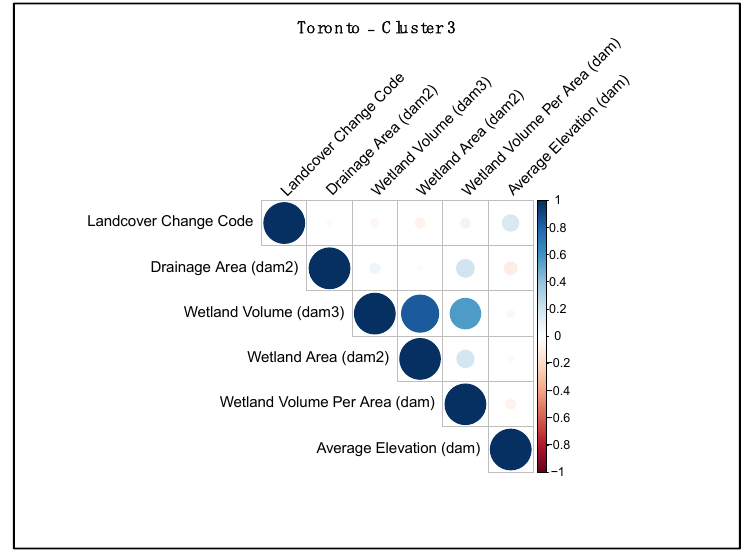
Figure 4. Toronto cluster 3 correlation matrix.